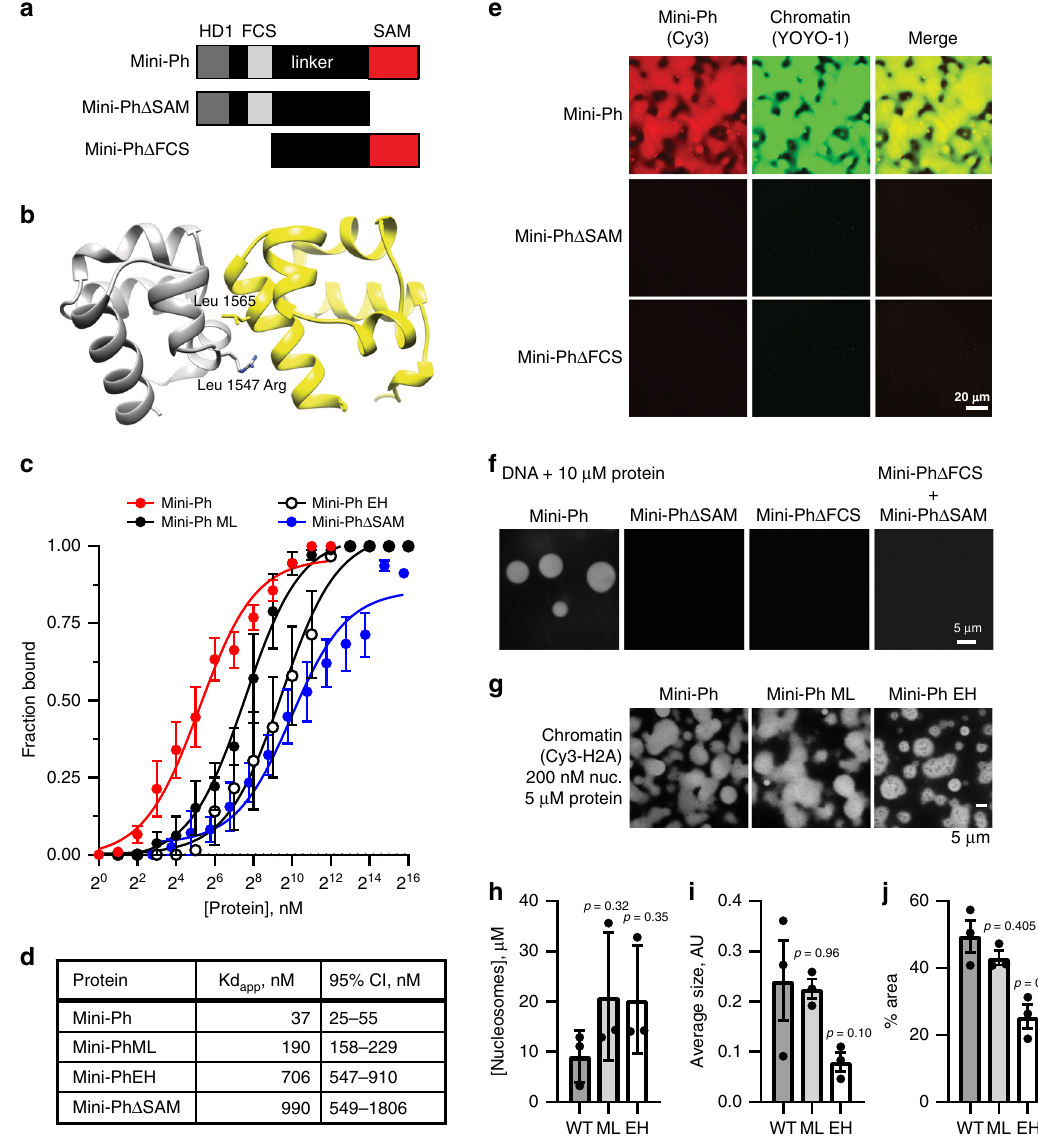
Fig. 3 Ph SAM, but not its polymerization activity, is essential for condensate formation in vitro. a Schematic diagram of Mini-Ph truncations. b Structure of the Ph SAM – SAM interface indicating the position of the ML and EH mutations that impair SAM polymerization. The EH mutation (Leu 1565 Arg) has a stronger effect on polymerization than the single ML mutation (Leu 1547 Arg). The fi gure was prepared from the structure of the ML mutant, PDB 1D 1KW4. c Summary of fi lter-binding experiments to measure DNA binding. Points show the mean ± SEM (independent experiments: Mini-Ph n = 10; Mini-Ph-ML n = 3; Mini-Ph EH n = 5; Mini-Ph Δ SAM n = 4). d Kd app with 95% CI for each protein, calculated from the data shown in C using Eq. (2). e